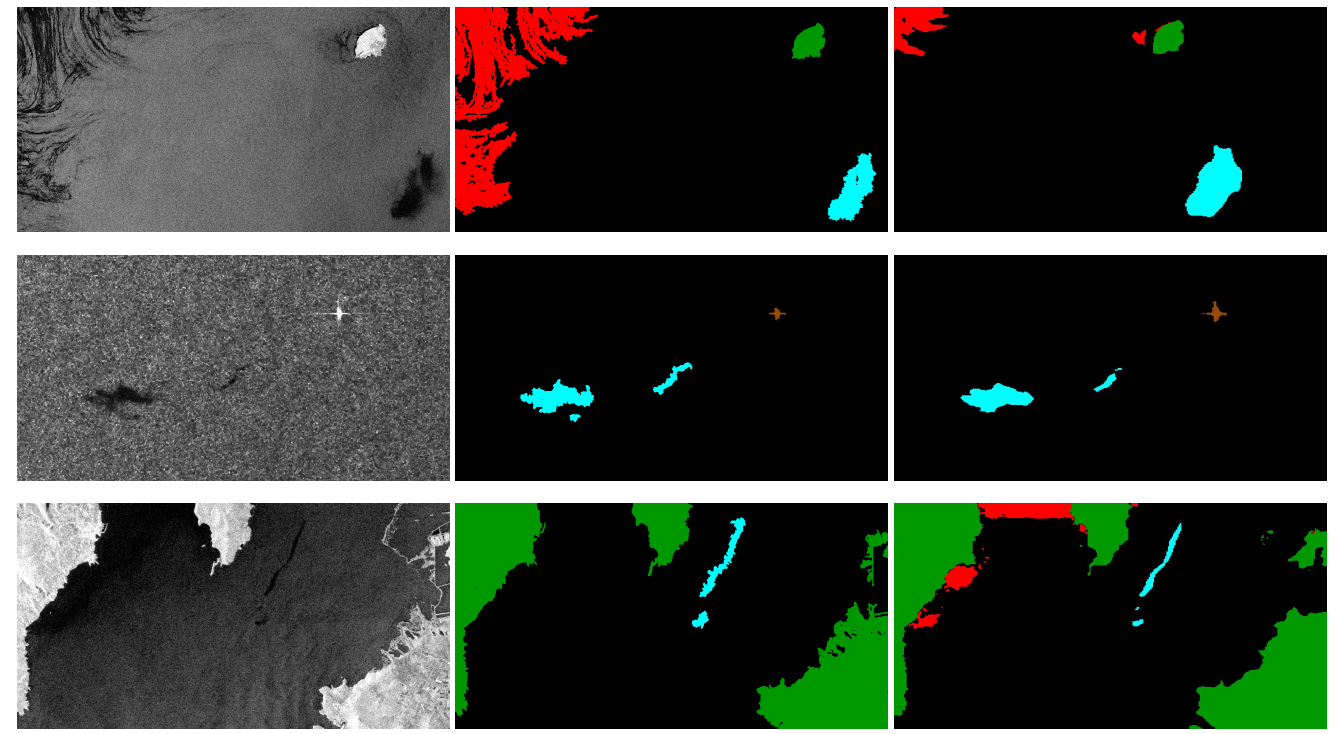
Figure 7. SAR images ( left ) along with ground truth masks ( center ) and predicted class labels ( right ). The classification framework used is based on UNet architecture with resnet101 pretrained encoder backbone, trained with a combination of focal, Jaccard, and GP loss functions. The images are acquired by Sentinel 1, and the training/test dataset is developed by MKLab ITI-CERTH,